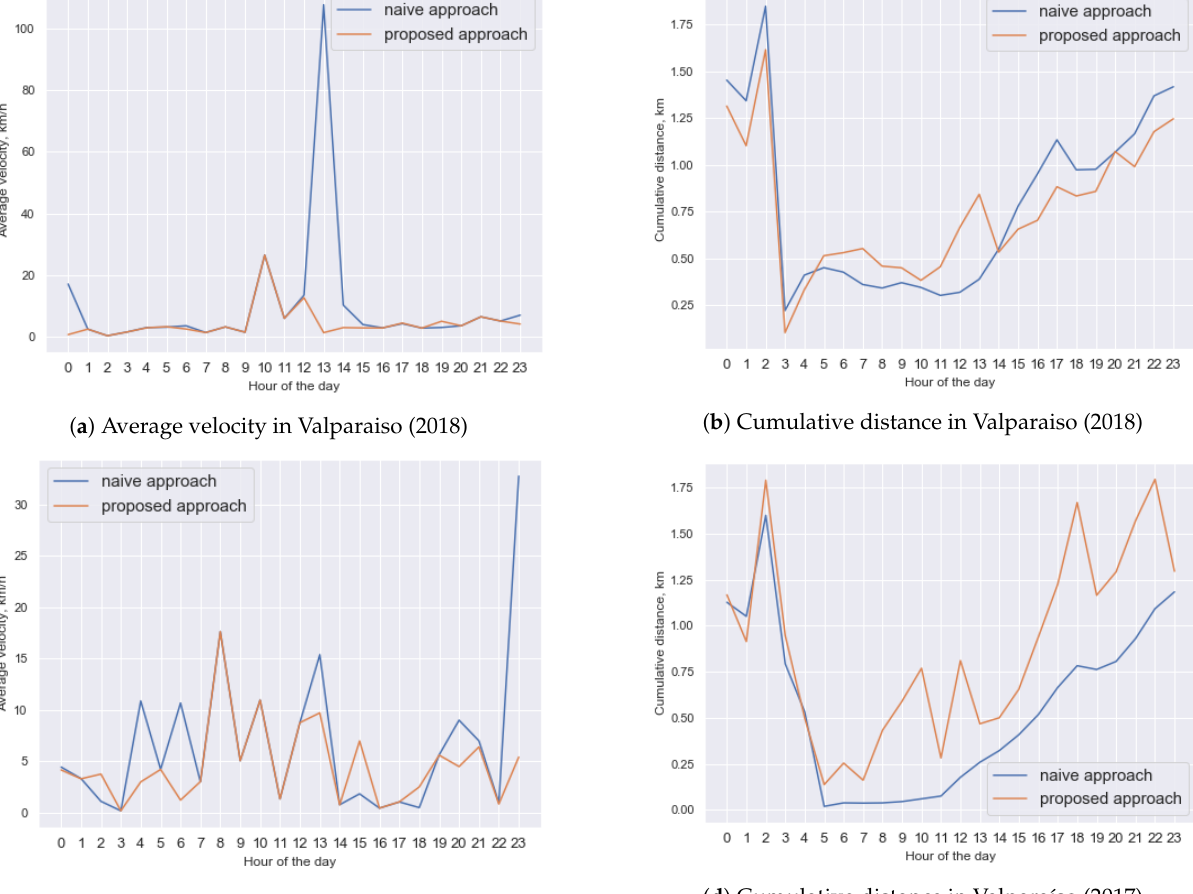
Figure 14. Naive and proposed approaches evaluated on full data sets for 1 January 2018, and 6 March 2017 in